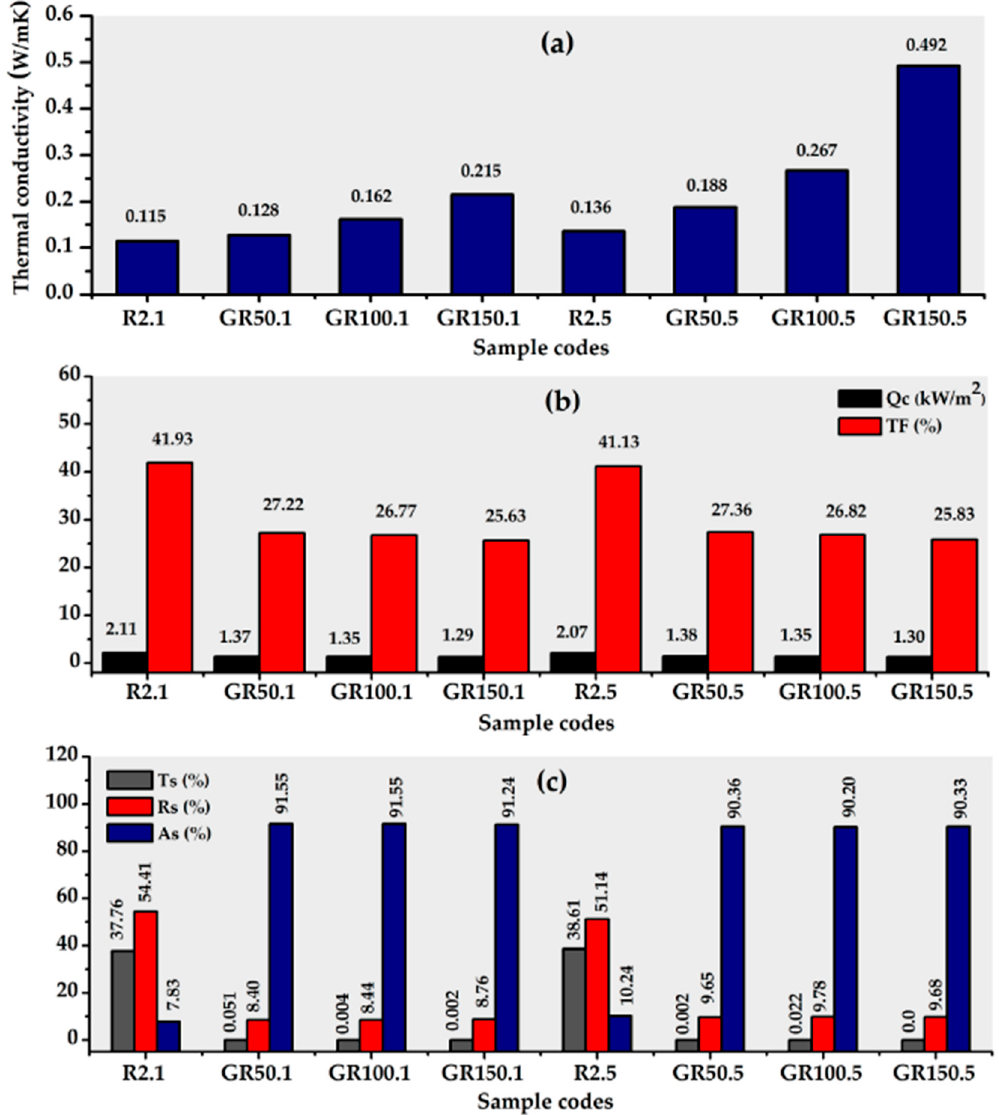
Figure 10. Thermal results according to the JIS R 2618 standard [19] ( a ); thermal results according to the EN ISO 6942 standard [18] ( b ); and spectrophotometry results of the reference and graphene-coated fabrics [20,21] ( c ).